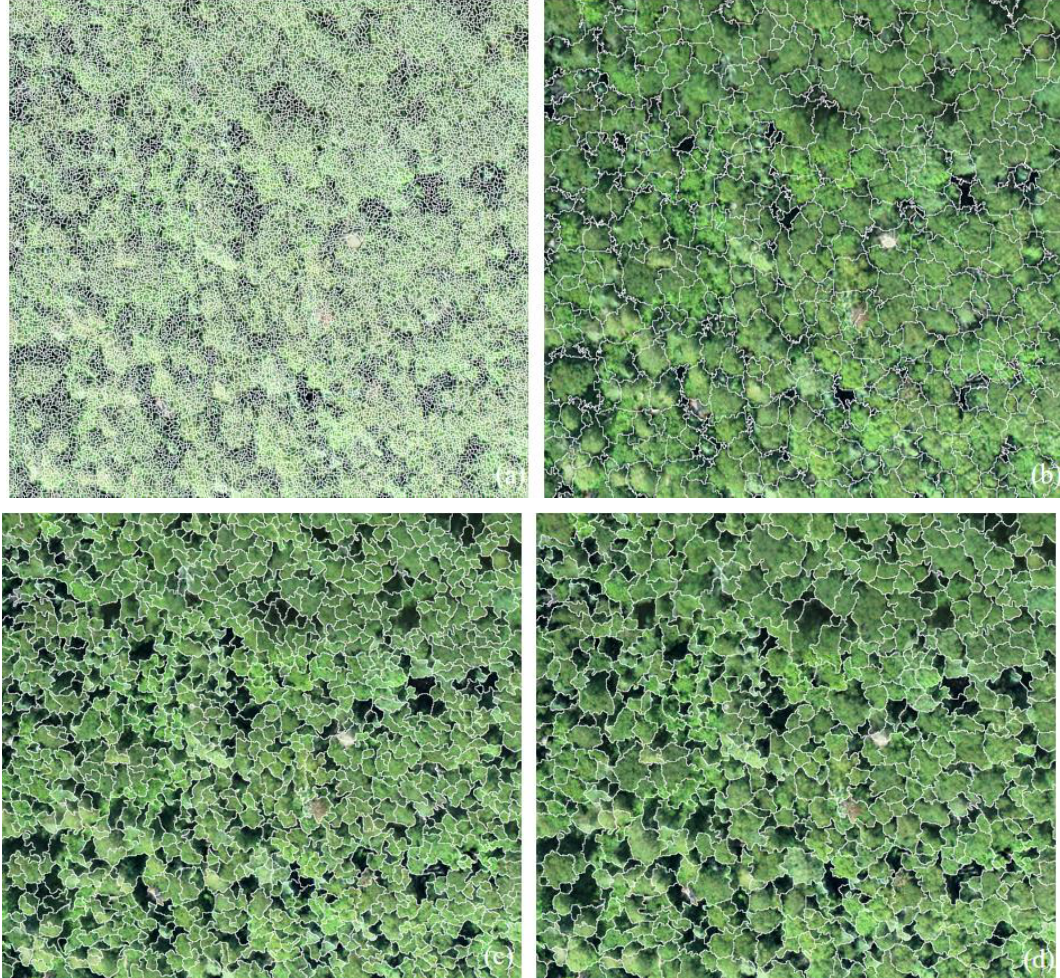
Figure 12. The tree crown maps of the deciduous forest plot obtained by the traditional watershed segmentation ( a ), the Crown Slices from Imagery (CSI) ( b ), the commonly used marker-controlled watershed segmentation (MWT) ( c ), and the proposed (SMS) ( d ) methods, respectively.